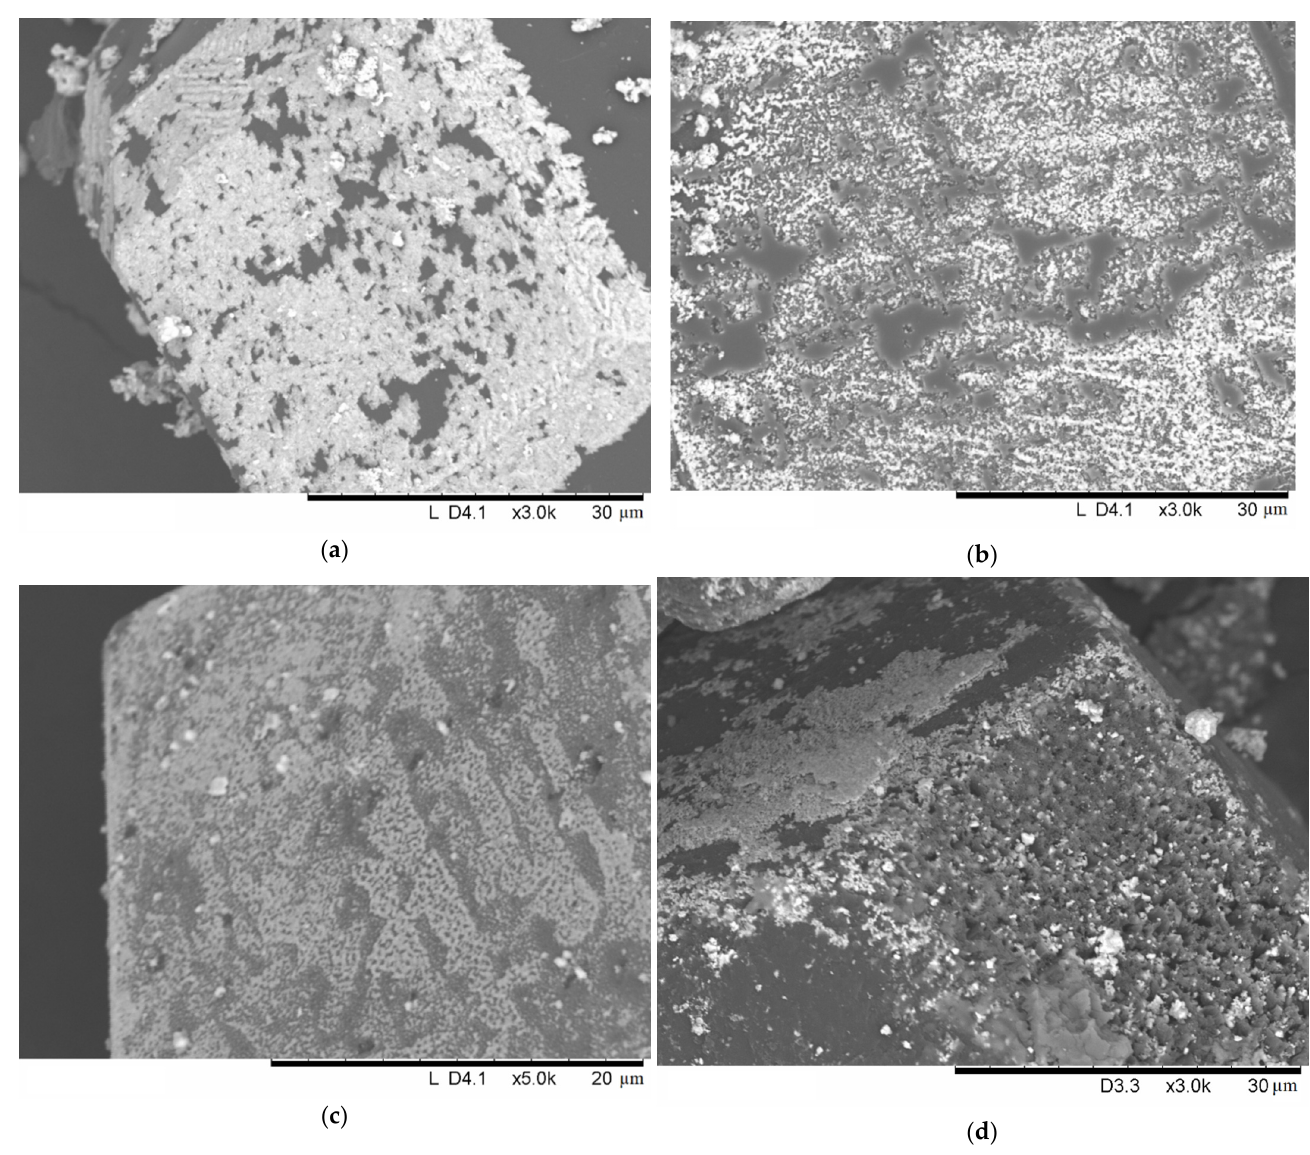
Figure 9. Surface morphology of a {100} diamond facet: 10-1000-15-HP ( a ), 10-1000-30-HP ( b ), 10-1000-15-SPS ( c ), and 50-1000-15-HP ( d ).